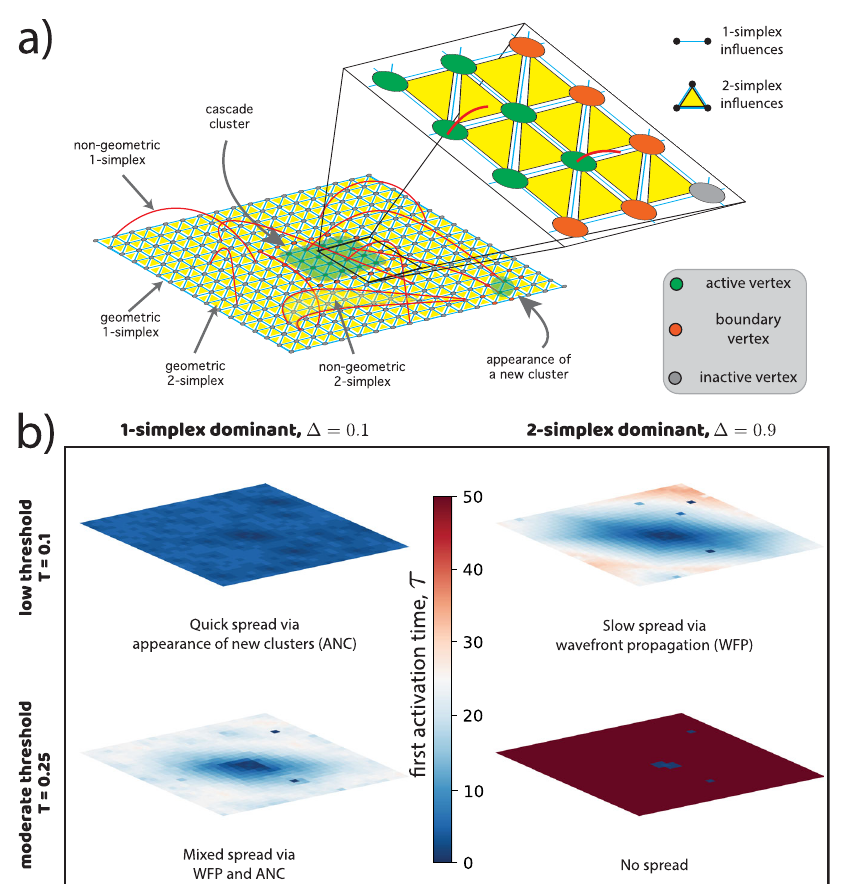
Fig. 1 Local and nonlocal spreading patterns for a simplicial threshold model cascade. a We initialize a simplicial threshold model (STM) cascade near the center of a two-dimensional (2D) noisy geometric complex, which contains both short-range geometric k -simplices and long-range non-geometric k - simplices. In this example, we study the clique complex 80 associated with a spatial graph in which vertices are arranged in 30 × 30 triangular lattice (yielding a “ geometrical substrate ” comprised of vertices and geometric 1- and 2-simplices) and non-geometric edges are added uniformly at random (yielding a “ topological noise ” that manifest by non-geometric k -simplices in the clique complex). STM cascades can propagate by either local wavefront propagation (WFP) over a geometrical substrate or non-locally over non-geometric simplices to yield appearances of new clusters (ANC). Propagation to any boundary vertex v i — which is inactive but has active simplicial neighbors (i.e., adjacent 1-simplices, 2-simplices, etc.) — requires that the total activity across its simplicial neighbors (which can be aggregated in different ways) surpasses a threshold T . b We study 2D STM cascades that utilizes k -simplices with dimension k ≤ κ = 2, the relative interaction strength of 2-simplices versus 1-simplices is tuned by a parameter Δ ∈ [0, 1] (see Eq. (2)). We depict the in fl uence of T and Δ on cascades' spatio-temporal patterns by visualizing the activation times τ i at which each vertex v i fi rst becomes active. When T and Δ are both small (top-left subpanel), STM cascades rapidly progress via ANC, yielding a “ splotchy ” pattern. Increasing either T or Δ suppresses ANC, thereby robustly guiding cascades along a geometrical substrate despite the presence of non-geometric k -simplices. (Observe in the bottom-right subpanel that STM cascades will not spread if T and/or Δ are too large.) In summary, multidimensional interactions and thresholding can coordinate to direct how and where cascades spread, which has implications for neuronal avalanches and other spatio-temporal cascades. See Section “ Simplicial cascades robustly follow geometrical substrates and channels ” for further experiment